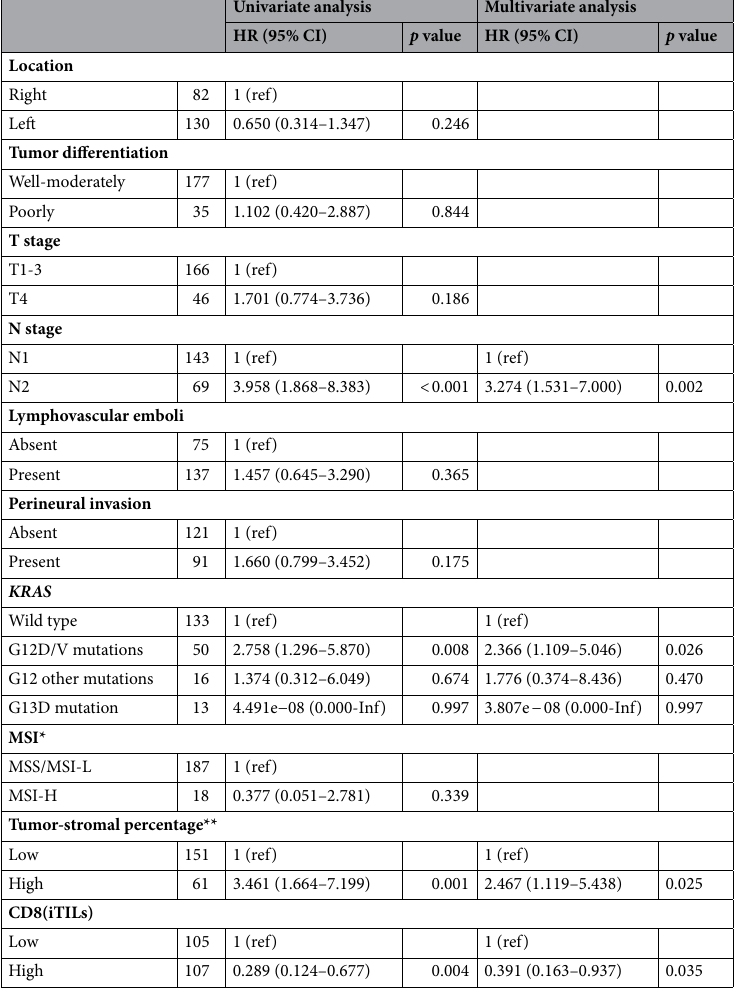
Table 3. Univariate and multivariate analyses in the validation cohort. *MSI status was determined in 205 patients with CRC. **CRCs were divided into a high group (upper one quartile of the tumor stromal percentage) and a low group (lower three quartiles of the tumor-stromal